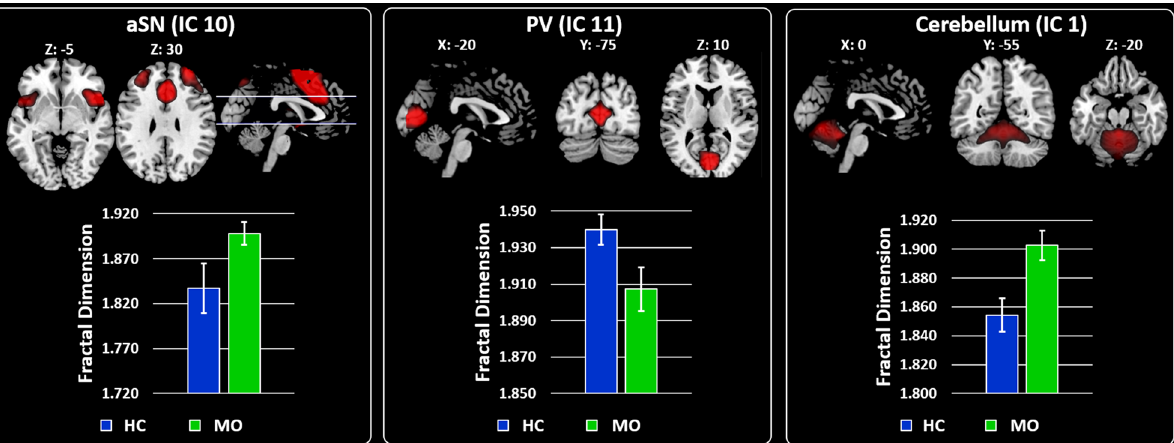
Figure 2. RSNs BOLD characterization by Higuchi’s fractal dimension (FD). For each panel (Left, Middle and Right)—Spatial maps of the IC obtained by GIFT toolbox. Grand average and standard error for the FD values ( k = 12) are shown for both groups HC (blue) and MO (green). Left panel—Shows the results obtained for IC10 representing the aSN. Middle panel—Shows the results for IC 11 representing the PV. Right panel—Shows the results for IC 1 representing the Cerebellum. All images have been co-registered into the Montreal Neurological Institute (MNI) space. The numbers above each image refers to the X, Y and Z coordinates in MNI space. aSN anterior part of the salience network, PV primary visual network.